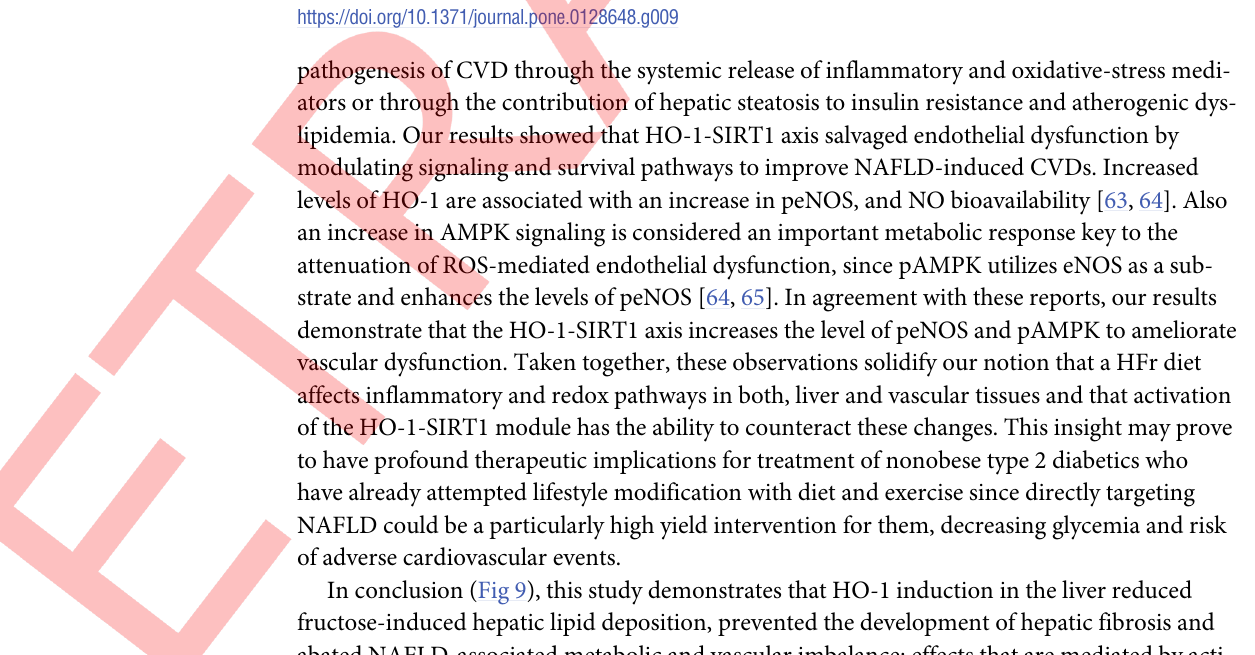
Fig 9. Schematic demonstrating HO-1 induction attenuates fructose-induced hepatic lipid deposition, prevent the development of hepatic fibrosis and abate NAFLD-associated vascular dysfunction; effects that are mediated by activation of the SIRT1 gene